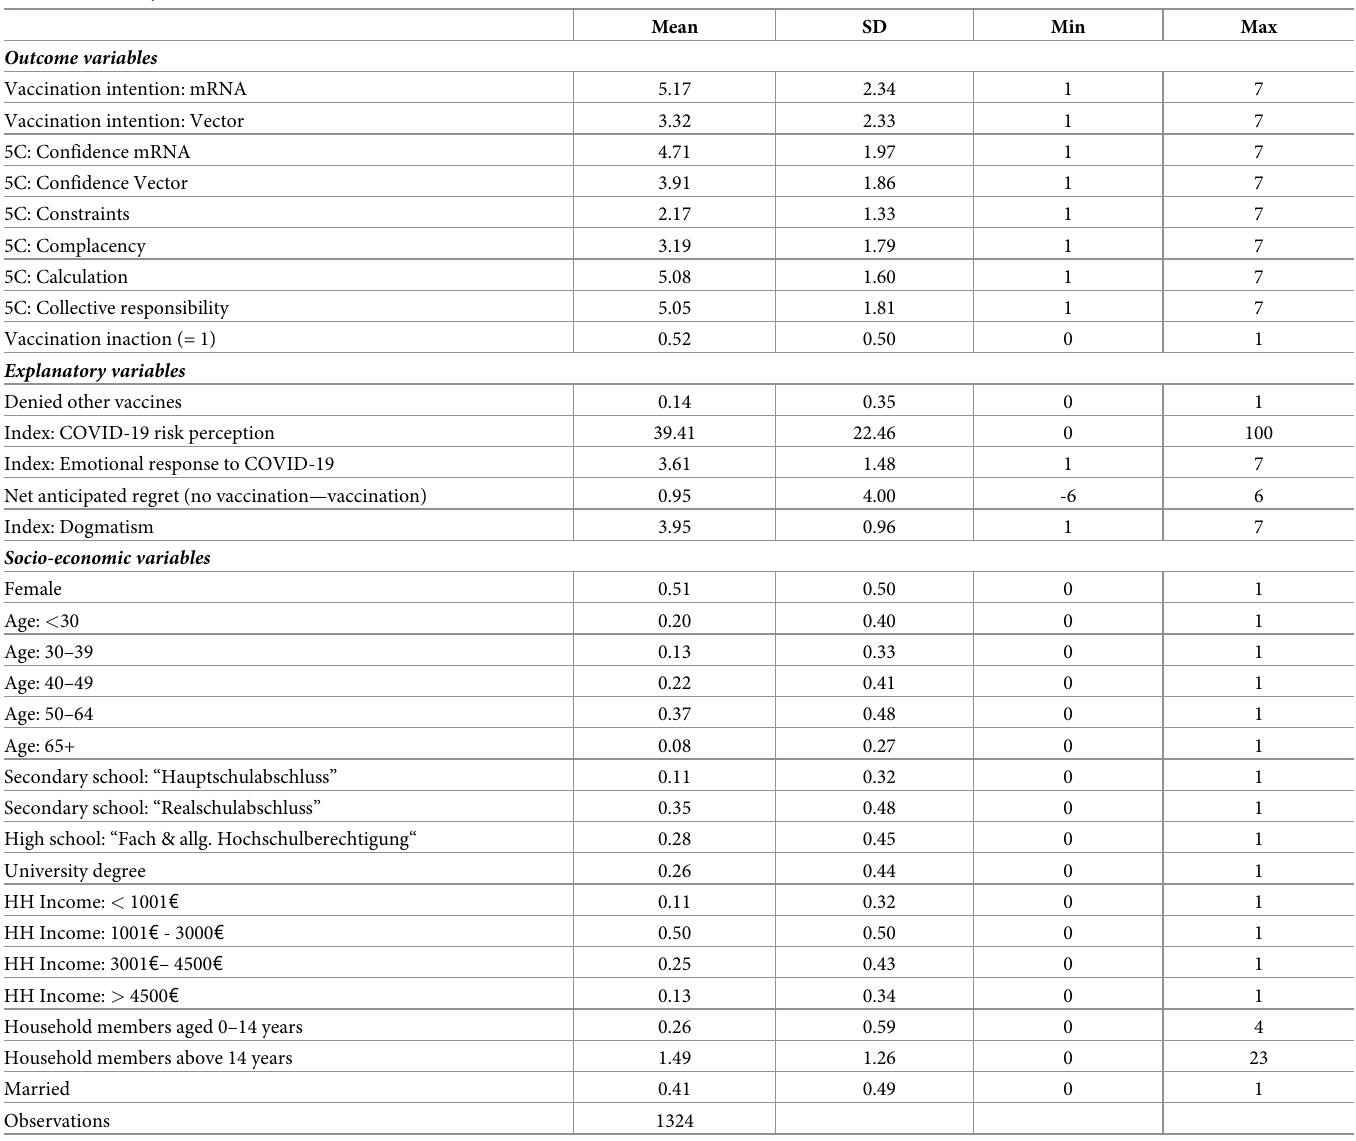
Table 1. Summary